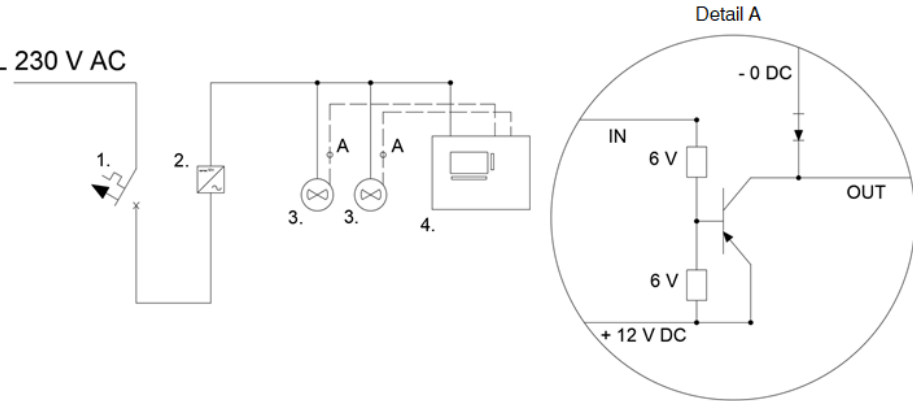
Figure 1. Electrical diagram of the system: (1) B6 overcurrent fuse, (2) ZI-20 power supply, (3) FT210 flow meters, and (4) PLC APB-12MRDL.